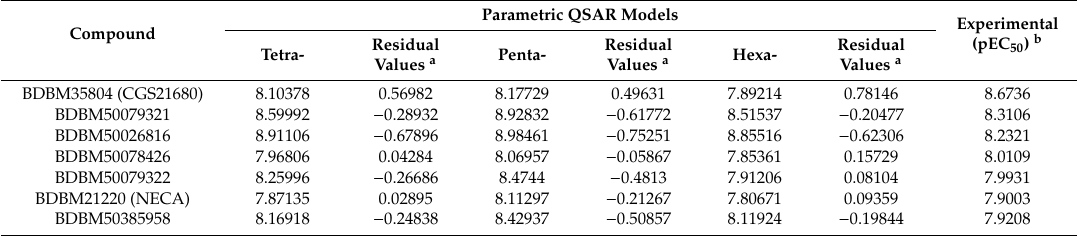
Table 5. External validation using the best built QSAR models (tetra-, penta-, and hexaparametic) with selected compounds from the Pubchem database.